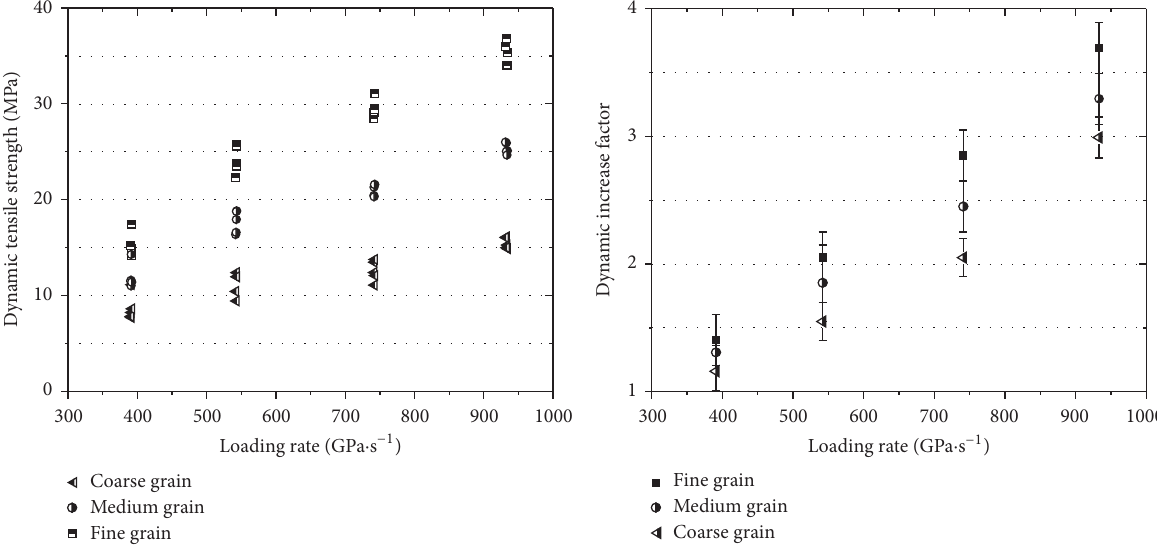
Figure 13: The relationship of loading rate dependence and dynamic tensile strength increase index of three kinds of grain sizes.